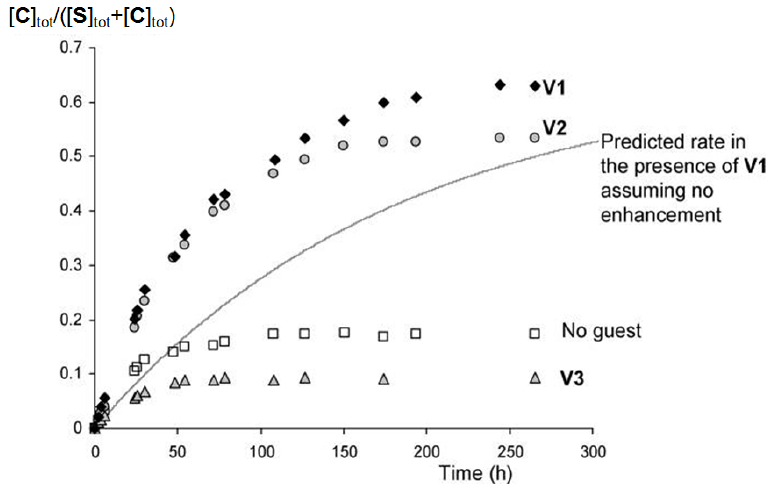
Figure 9. Kinetics of the switching of S (1 × 10 − 3 M) to C in the absence of guest ( )